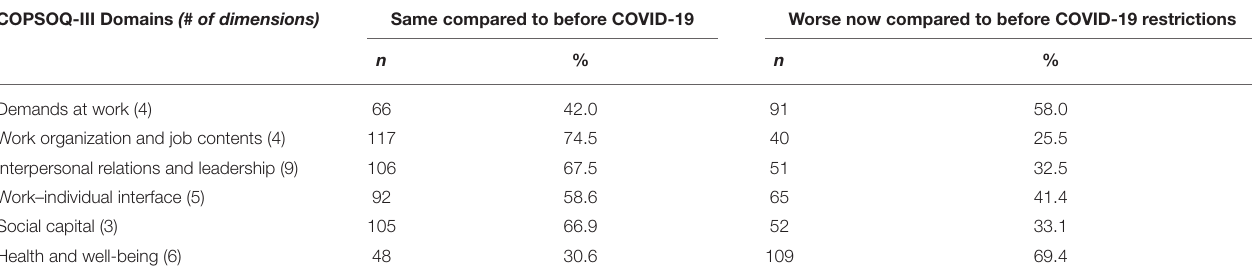
TABLE 5 | Number and proportion of respondents reporting the COPSOQ-III domains had remained the same vs. worsened, since COVID-19 restrictions. COPSOQ-III Domains (# of dimensions)